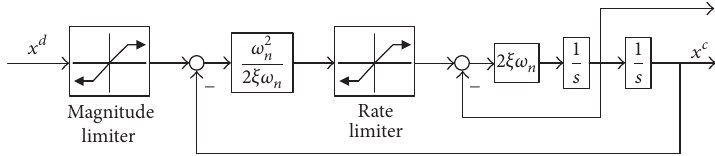
Figure 2: Structure of constrained command